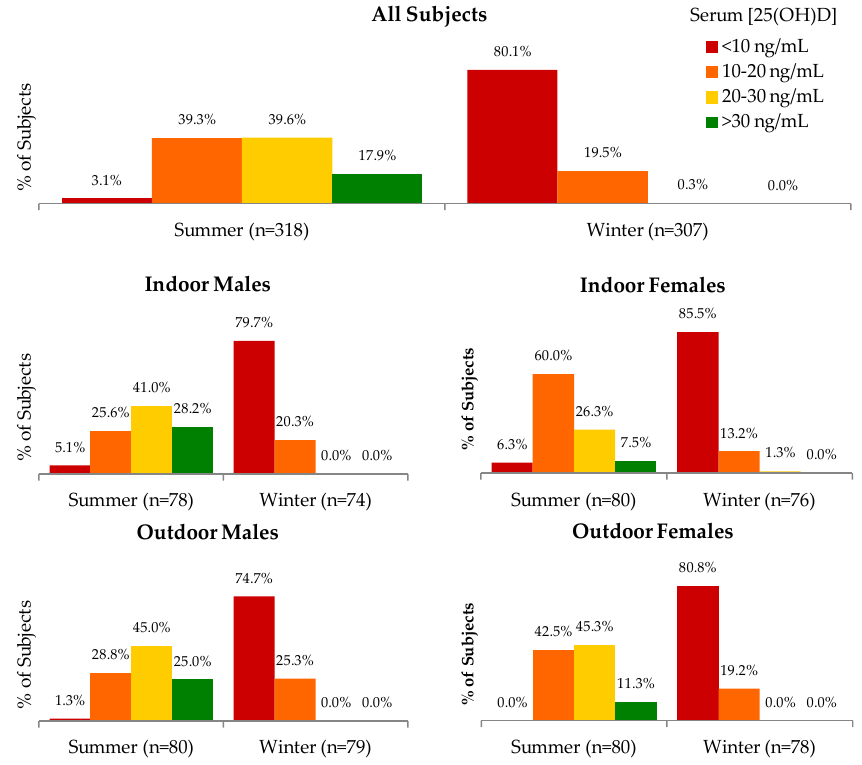
Figure 3. Prevalence of serum 25(OH)D concentration categories according to season, occupation, and sex subgroups (red: <10 ng/mL, orange: 10 to 20 ng/mL, gold: 20 to 30 ng/mL, green: >30 ng/mL).